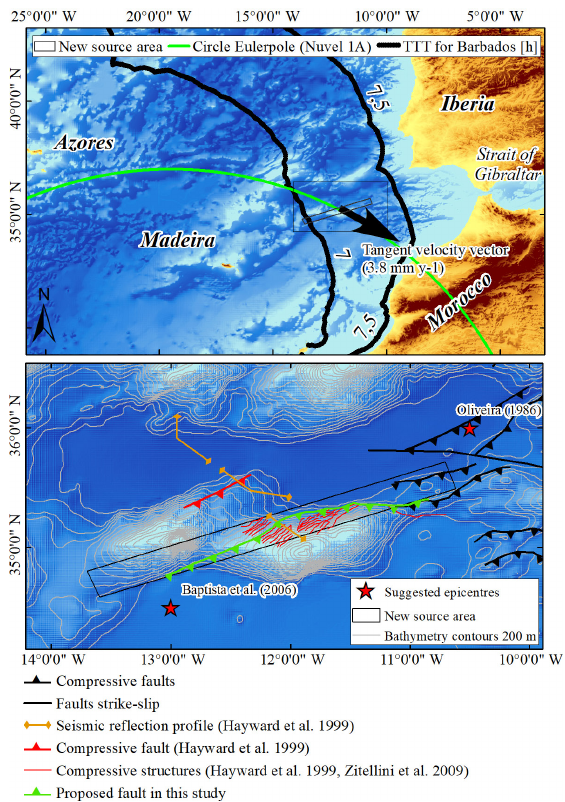
Figure 3. A circle around the Euler pole at the proposed possible source location. The model Nuvel 1A (DeMets et al., 1994, 1999) computes a 3.8mmyear − 1 convergence. We plot the tangent veloc- ity vector close to the candidate source. The black lines depict the backward ray-tracing contours in hours, for a tsunami travel time (TTT) of 7–7.5h to Barbados. In the inset, the black lines plot the thrust and strike-slip faults. The red lines depict the faults and struc- tures proposed in Hayward et al. (1999). The orange lines show the location of the seismic profiles for the areas of the Coral Patch and Ampere seamounts (Hayward et al., 1999). The green line identi- fies the proposed tectonic structure used in this study. The red stars are the locations of the closest proposed epicentres (Baptista et al., 2006; Oliveira,